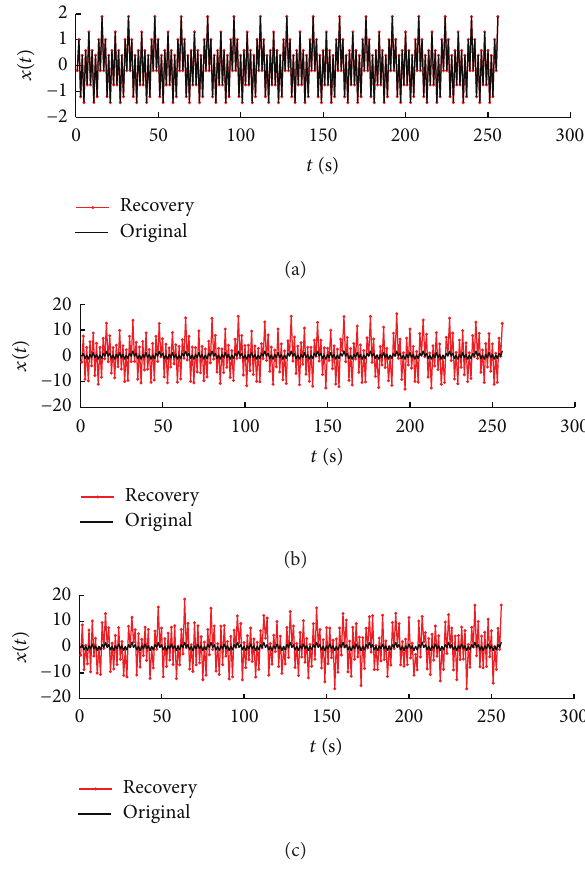
Figure 1: (a) Recover 𝑥 from 𝑦 = 𝐴𝑥 + 𝑒 . The error of the re- covered signal value and original signal value is 6.4835𝑒 − 004 by the Euclidean norm which indicates that the recovered signal and originalsignalarealmostthesame.(b)Recover 𝑥 from 𝑦 = 𝐴(𝑥+𝑢)+ 𝑒 .Theerroroftherecoveredsignalvalueandtheoriginalsignalvalue is 6.2258 by the Euclidean norm which means that the recovered signal and original signal are quite different. (c) Recover 𝑥 from 𝑦 = (𝐴+𝐸)(𝑥+𝑢)+𝑒 . The error of the recovered signal value and the originalsignalvalueis 5.8855 bytheEuclideannormwhichindicates that the recovered signal is much different from the original signal. Compared with the change (error) between the recovery signal and the original signal in (a), the changes (errors) in (b) and (c) differ little. What is more, comparing the change between the recovery signal and the original signal of (c) with that of (b), the change of (c) is quite a little bigger because 𝐸 is involved in (c) but 𝐸 is not involved in